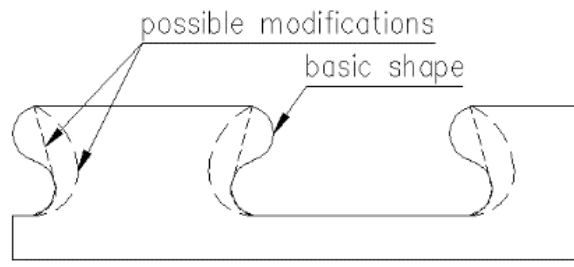
Figure 21: Topology of the shapes of steel dowels considered for the purposes of